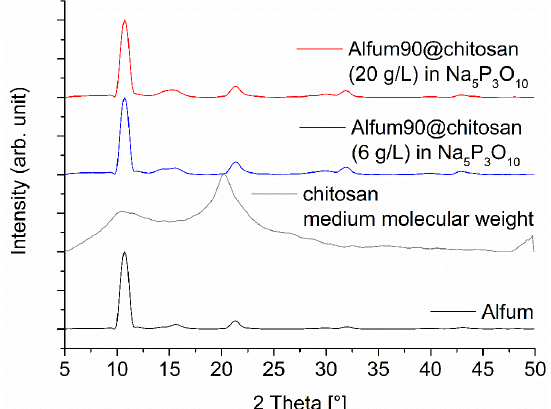
Figure 4. PXRD patterns of Alfum90@chitosan composites for a MOF content of 90 wt-%, prepared with different chitosan concentrations. The diffraction patterns for 60 and 80 wt-% Alfum@chitosan are shown in Figure S5 (Supplementary Information). The broad contribution from amorphous chitosan is only seen at lower MOF wt-% (Figure S5). The broadening of the PXRDs is related to the short measurement time of 6 min on the Bruker D2 phaser, which was used due to the large number of samples and is not related to a low crystallinity of the MOF (cf. Figure S3 in the Supplementary Information with the sharper reflexes measured on a Rigaku Miniflex). The PXRD of Alfum was obtained from the purchased MOF from BASF.